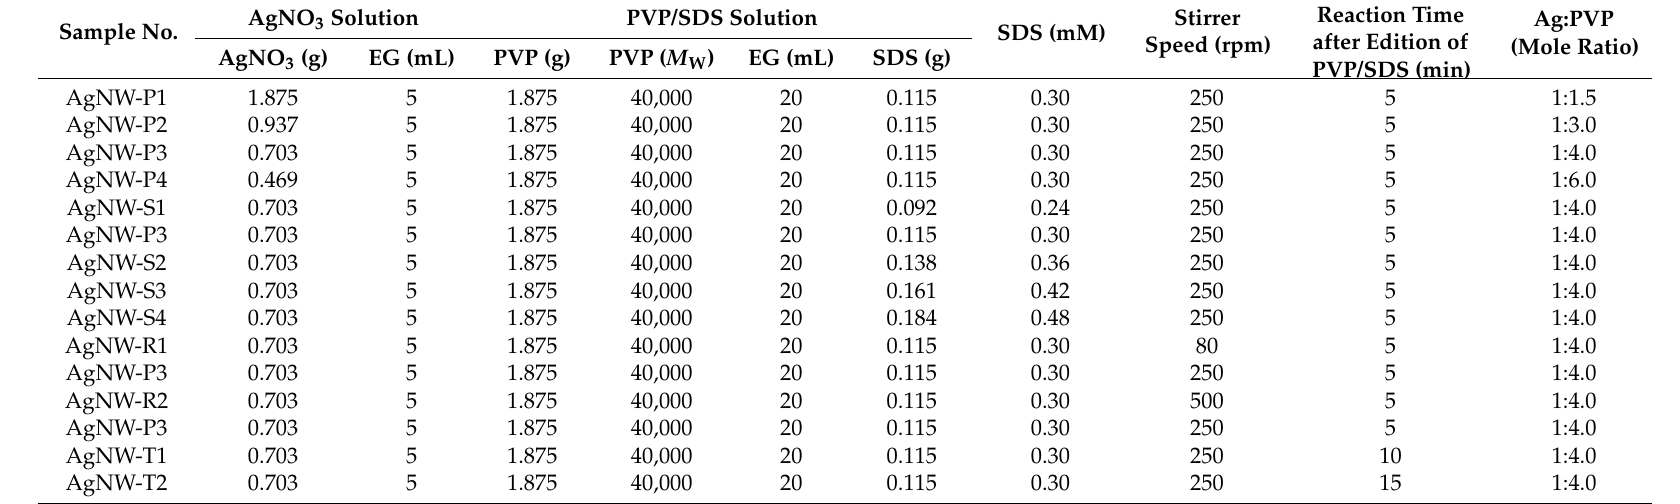
Table 1. Synthesis of AgNWs in batch type closed